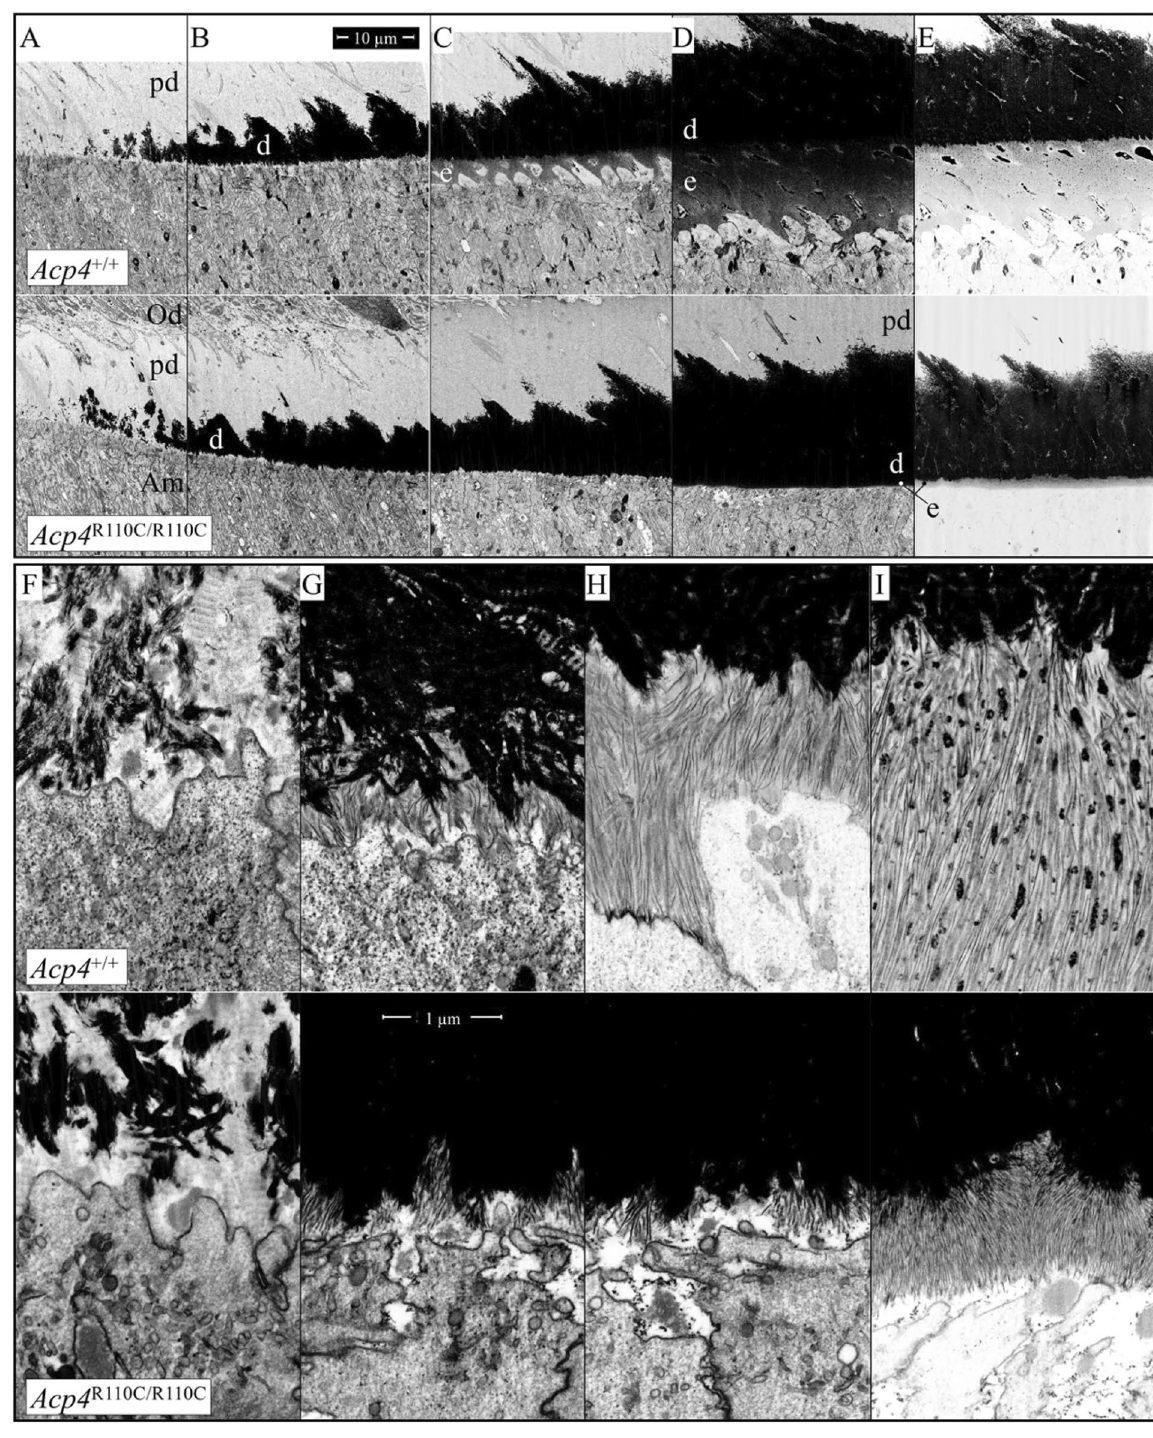
Figure 9. FIB-bSEM of 7-week Acp4 +/+ and Acp4 R110C/R110C Mandibular Incisors. To compare the ultrastructure of early enamel formed in Acp4 +/+ and Acp4 R110C/R110C mice, sites are sampled (1) after dentin mineralizes and before enamel secretion begins ( A , F ; Level 0.92), (2) just after enamel secretion starts ( B , G ; level 1.11), (3) transition from formation of the initial enamel layer to development of Tomes processes ( C , H ; level 1.20), and (4) early inner enamel layer formation ( D , I ; Level 1.33). ( E ) A brighter version of image of ( D ). Low magnification (mag) images ( A – E ) (2500×) with mag bar in ( B ); high mag images ( F – I ) (35,000×) with mag bar in ( G ). In Acp4 +/+ mice, initial enamel mineral ribbons appear to elongate away from the tips and sides of mineralized collagen fibers at the DEJ ( A , B ). This process continues as the enamel prongs map out the Tomes processes ( C ) and continue on with formation of rod and interrod areas typical of the inner enamel layer ( D ). In Acp4 R110C/R110C mice, initial enamel ribbons start to form sporadically ( F , G ), but ameloblasts are unable to elongate them to create an initial layer, enamel prongs or Tomes processes ( G , H ), thereby negating any further normal development of an enamel layer. Noticeably, those initial ribbons are not associated with the ameloblast cell membrane. The mineral crystals formed in the absence of normal ACP4 appear thin, short in length and closely compressed close to each other ( I ). Am, ameloblasts; d, dentin; e, enamel; Od, odontoblasts; pd: